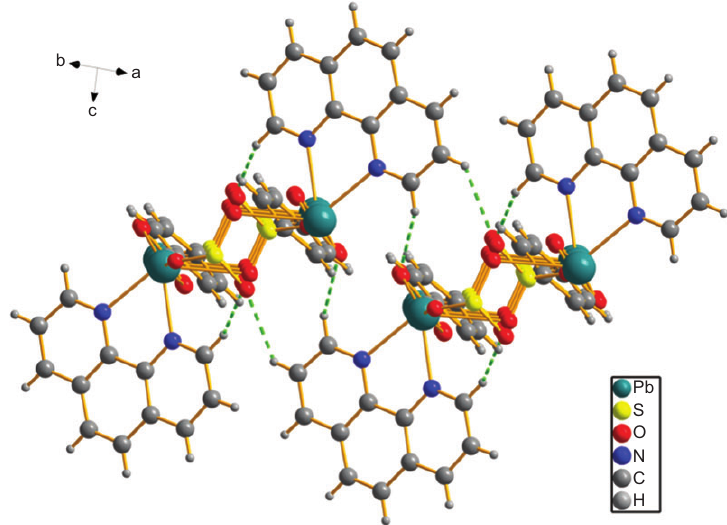
Figure 4 Hydrogen bonding (green dashed lines) in the complex.